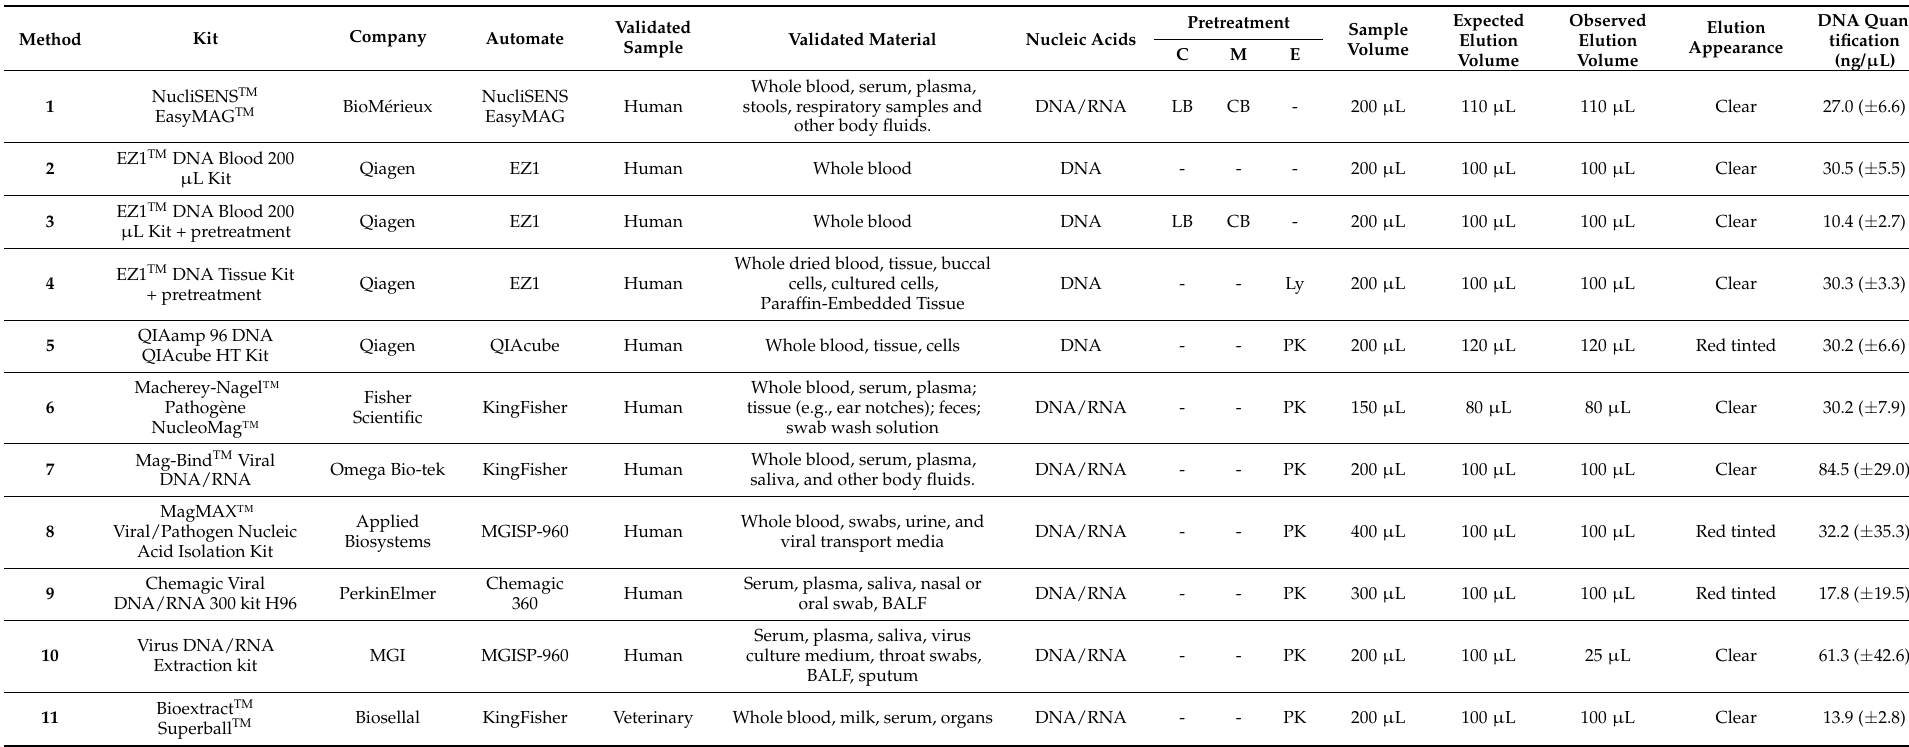
Table 1. Characteristics of the DNA extraction methods. The DNA extract measured by Nanodrop is expressed as a mean concentration ( ± standard deviation) C: chemical; M: mechanical; E: enzymatic; LB: NucliSENS TM easyMAG TM lysis buffer (BioM é rieux, Marcy-l’Etoile, France); CB; ceramic beads; Ly: lyticase; PK: proteinase K; BALF: broncho-alveolar lavage fluid, DNA: deoxyribonucleic acid; RNA: ribonucleic